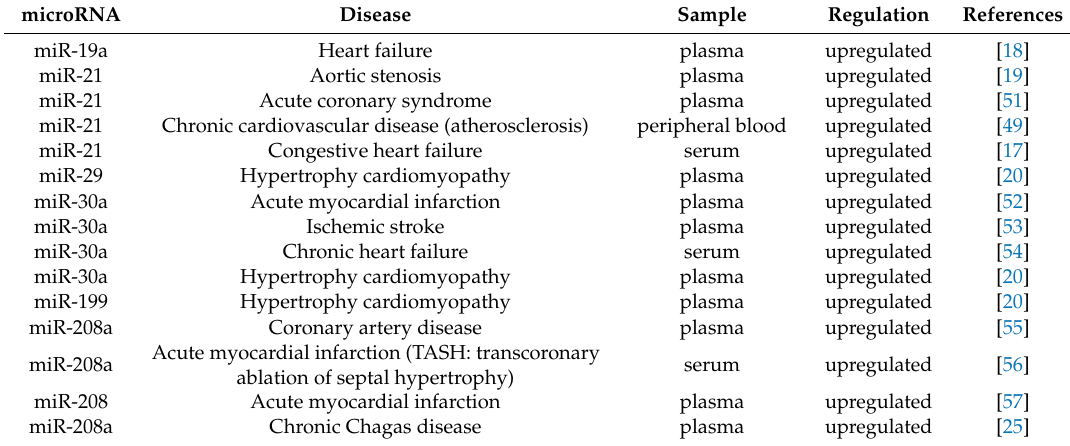
Table 3. Circulating microRNA expression levels in cardiovascular